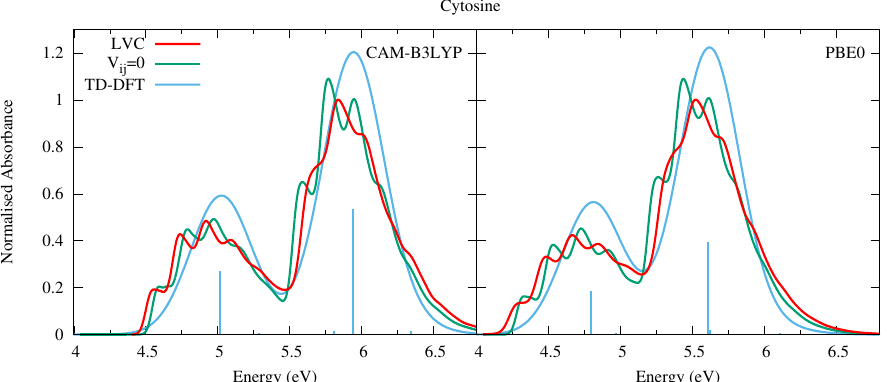
Figure 6. Absorption spectra of Cytosine from the LVC model (red), without inter-state coupling (green), and TD-DFT calculations with stick spectra (blue). Most intense peaks from LVC spectra normalised to 1, with other calculated spectra normalised with the same value. All calculated spectra unshifted. LVC spectra broadened with Gaussian HWHM 0.04 eV, TD-DFT with HWHM 0.25